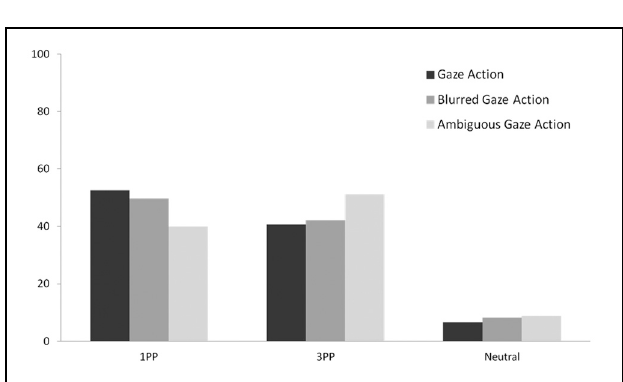
FIGURE 4 | Percentages of 1PP, 3PP and neutral responses in Experiment